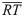
Formation of coalitions (Alpha > 0) and oppositions (Alpha < 0) in terms of the co-voting agreement (RCV).In the case of Twitter (the bottom charts), coalitions are indicated by higher average retweets (RT¯), and oppositions by lower average retweets.